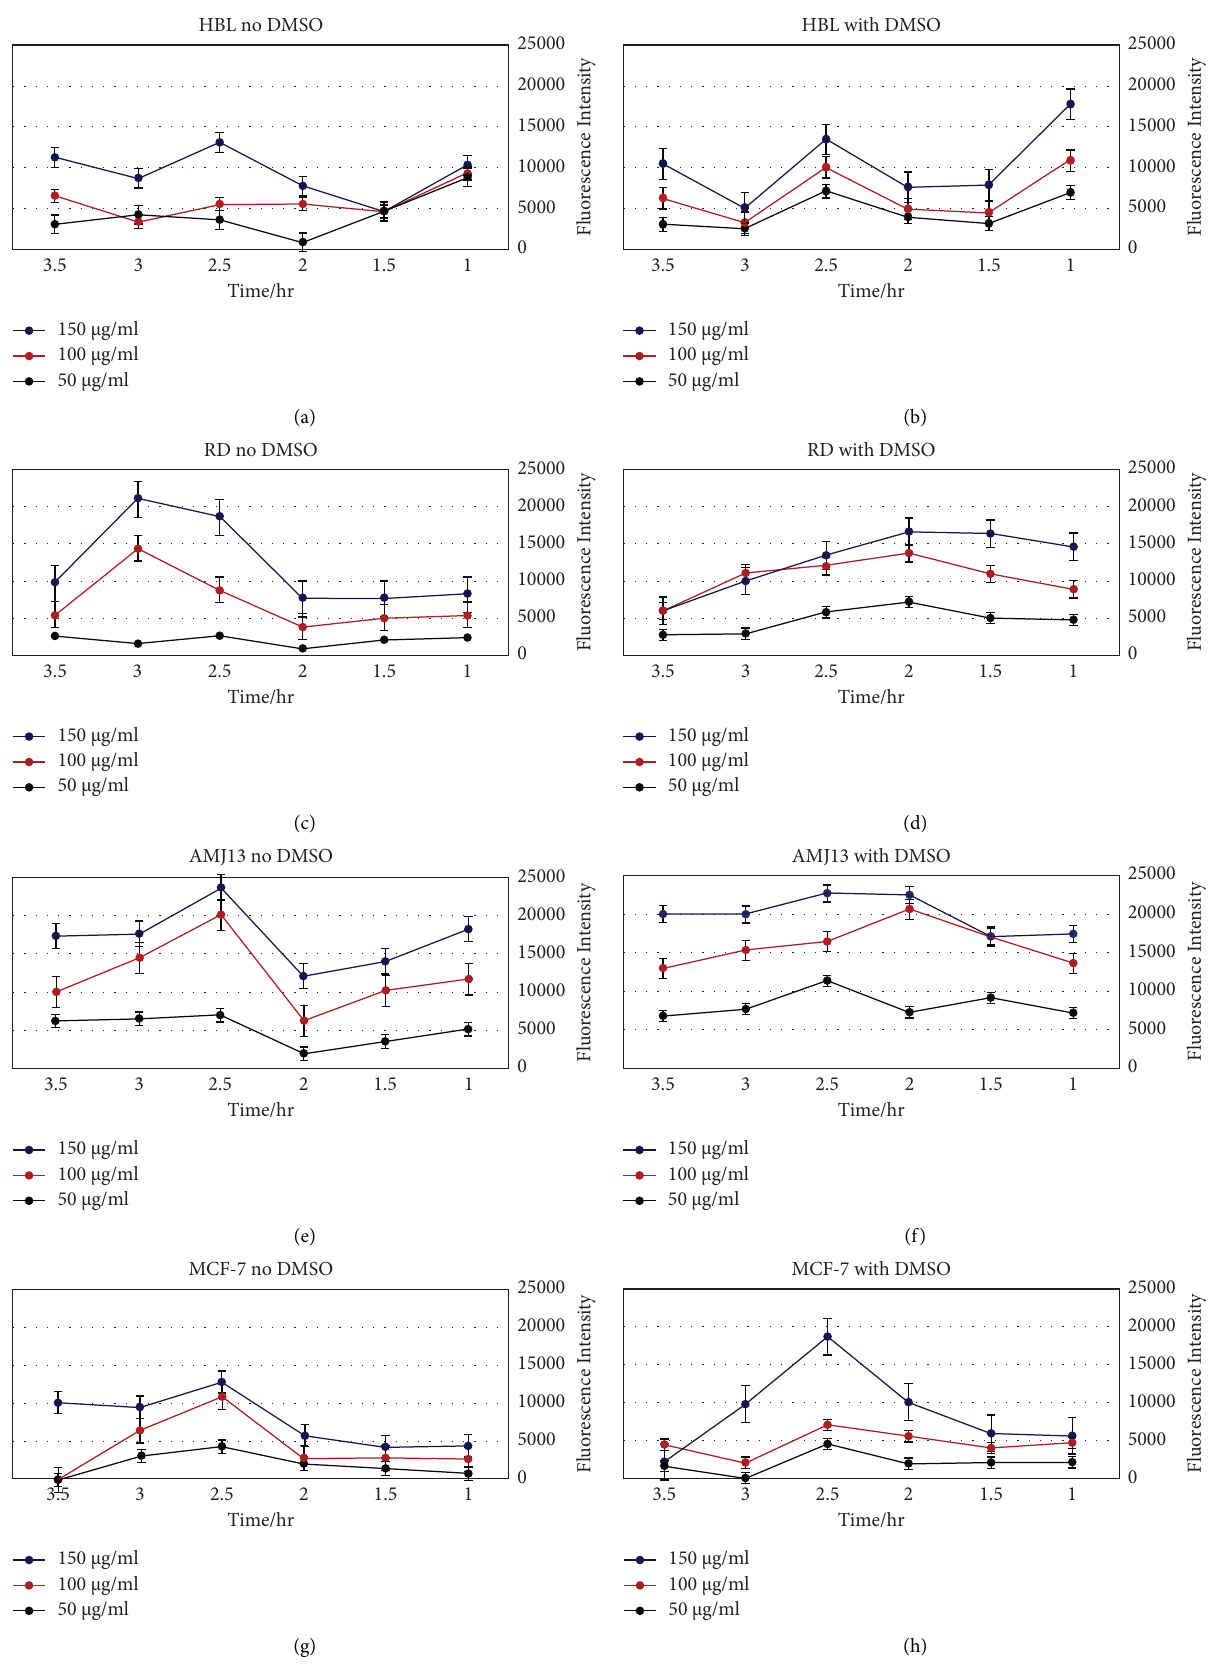
Figure 4: Te impact of ZnO NPs levels on imaging (150 and 100 ug/ml is higher than 50ug/ml). As contrasted to tumor cells, normal cells (HBL) exhibit lower fuorescence intensity to be identifed throughout all time